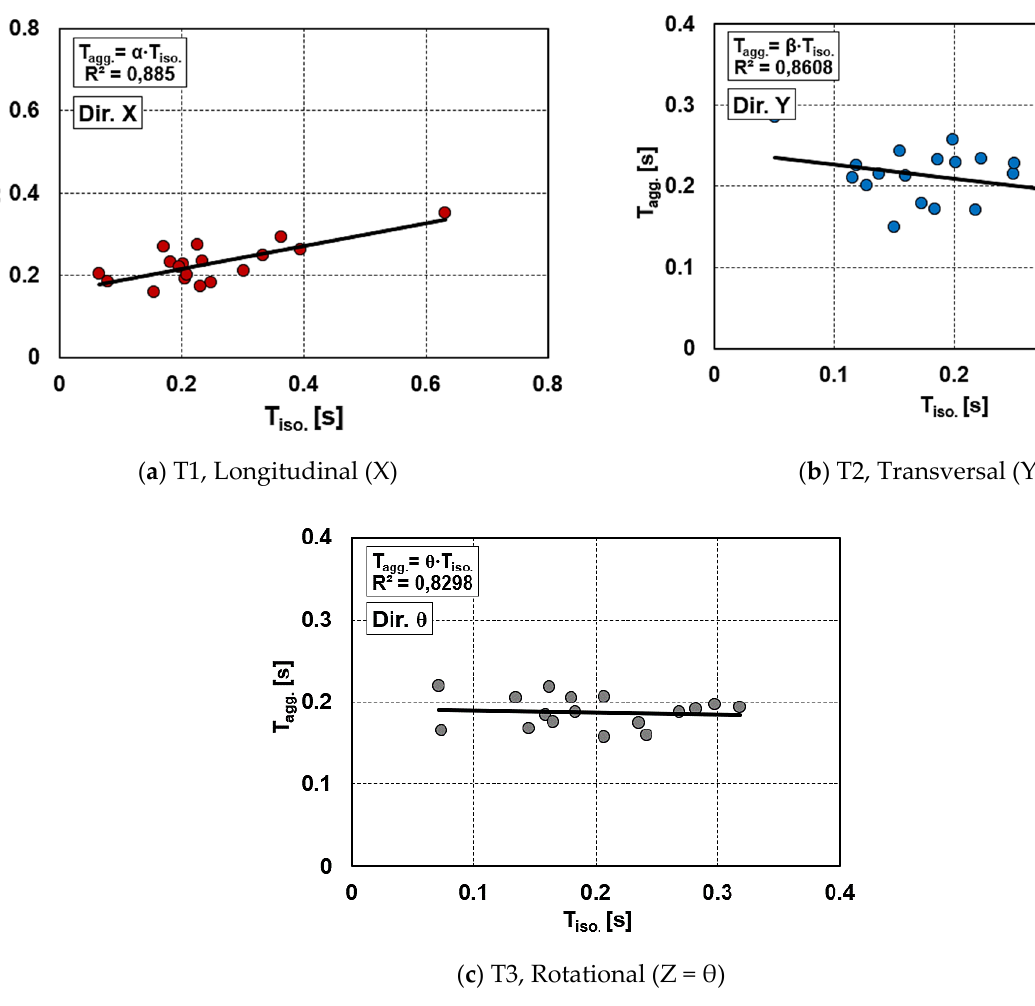
Figure 16. Linear regression relationships for estimation of the vibration periods of investigated SUs.